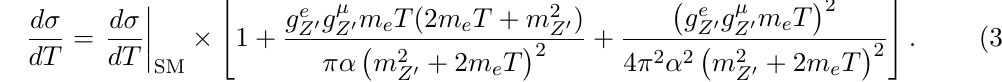
Figure 3 . Feynman diagrams of (cid:22) { e scattering mediated by a (cid:13)avor-conserving Z t -channel (left) or a (cid:13)avor-changing Z 0 boson in the s -channel